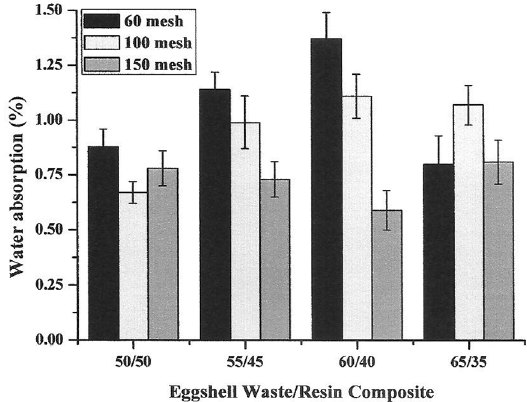
Figure 8. Water absorption of the cured artificial rock